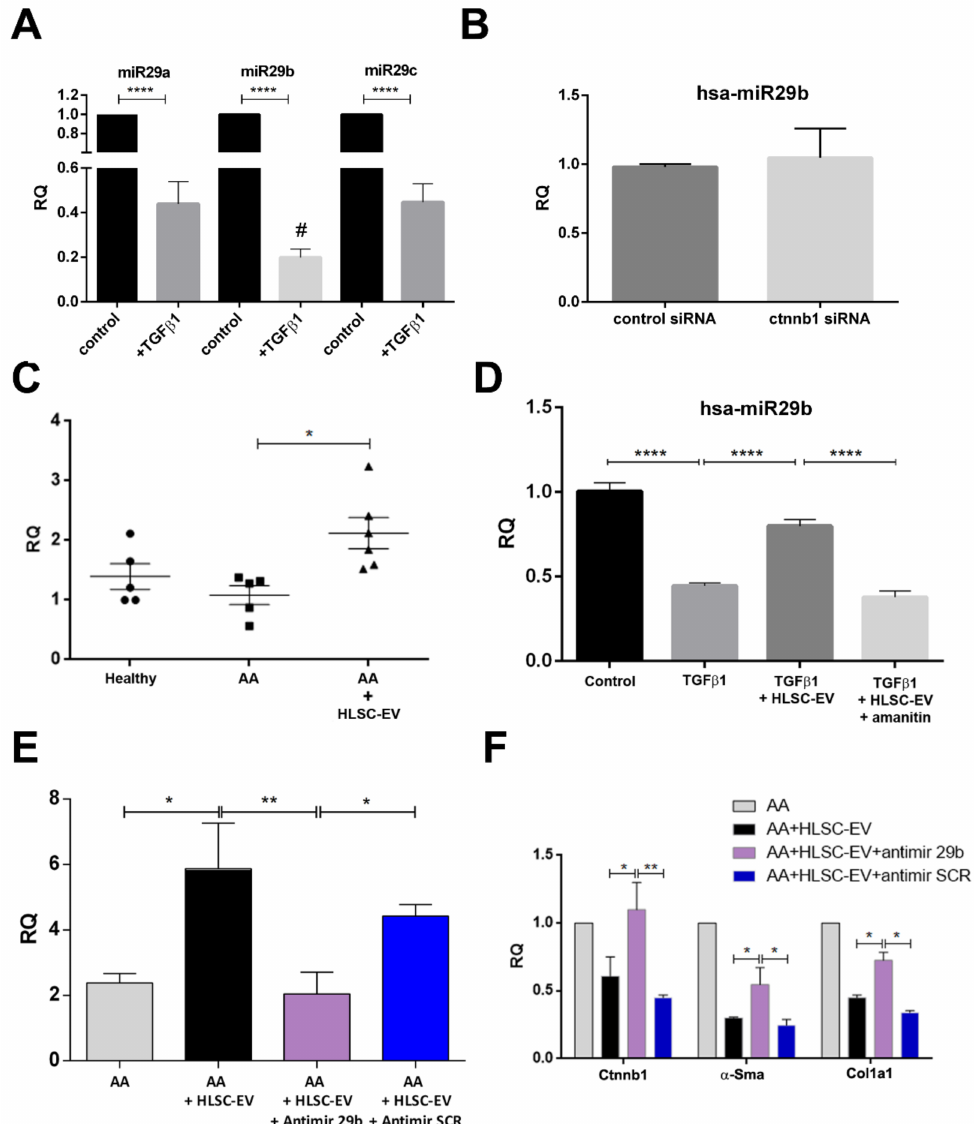
Figure 7. HLSC-EVs regulate β -catenin through miR29b. ( A ) Expression of hsa-miR29 a, b, and c in fibroblast treated with or without (control) TGF β 1 for 24 h at 37 ◦ C. Data represent mean ± SD of three independent experiments performed in triplicate, **** p < 0.001 control vs. TGF β 1; # p < 0.01 TGF β 1 miR29b vs. TGF β 1 mir29a and TGF β 1 miR29c. ( B ) Expression of hsa-miR29b in mkCF cells transfected with control siRNA or Ctnnb1 siRNA for 72 h. ( C ) Expression of miR29b in AAN mice experimental groups. A significant up-regulation of miR29b is observed in AAN mice treated with HLSC-EVs. * p < 0.05, (n = 5 mice per group). ( D ) RT-PCR showing the expression of miR29b in fibroblasts treated with TGF β 1 alone or TGF β 1 with HLSC-EVs, or with TGF β 1 with HLSC-EVs in the presence of α -Amanitin for 6 h at 37 ◦ C. Post-experimental analysis revealed a significant reduction in miR29b following treatment with TGF β 1, which was up-regulated in the presence of HLSC-EVs. HLSC-EV treatment in the presence of α -Amanitin showed no significant increase in the expression of miR29b. **** p < 0.0001 was considered statistically significant. ( E ) The expression of miR29b in fibroblasts co-cultured with mTECs pre-treated with AA increased following treatment with HLSC-EVs and was significantly reduced in the presence of antimiR29b. * p < 0.05, ** p < 0.01 was considered to be statistically significant. ( F ) Expression of β -catenin and pro-fibrotic genes in fibroblasts co-cultured with mTECs pre-treated with AA in the presence or absence of HLSC-EVs, or HLSC-EVs together with antimiR29b, or HLSC-EVs with antimiR SCR. * p < 0.05, ** p < 0.001 were considered to be statistically significant. Data represent mean ± SD of three independent